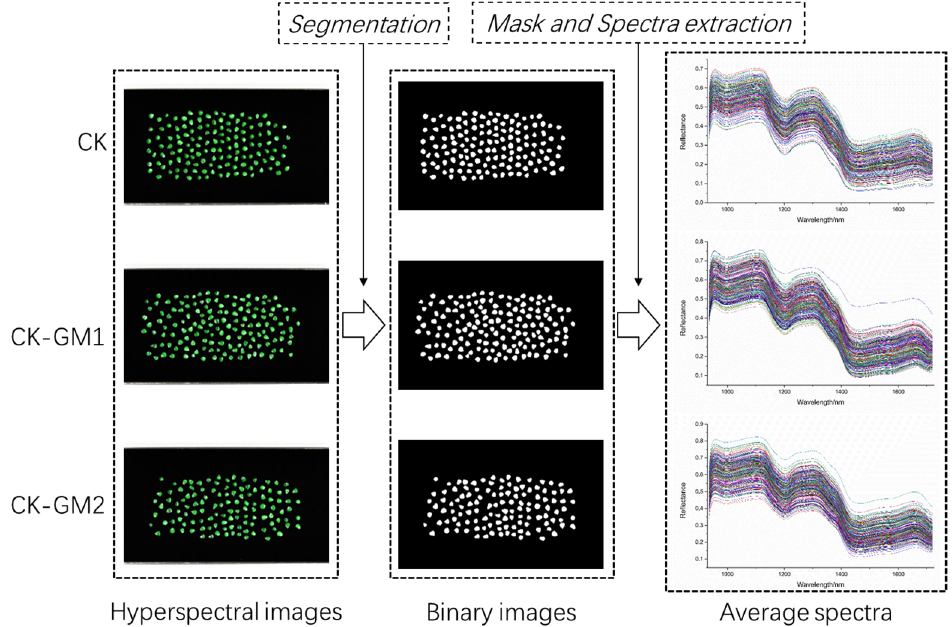
Figure 1. Process of spectra extraction from hyperspectral images.